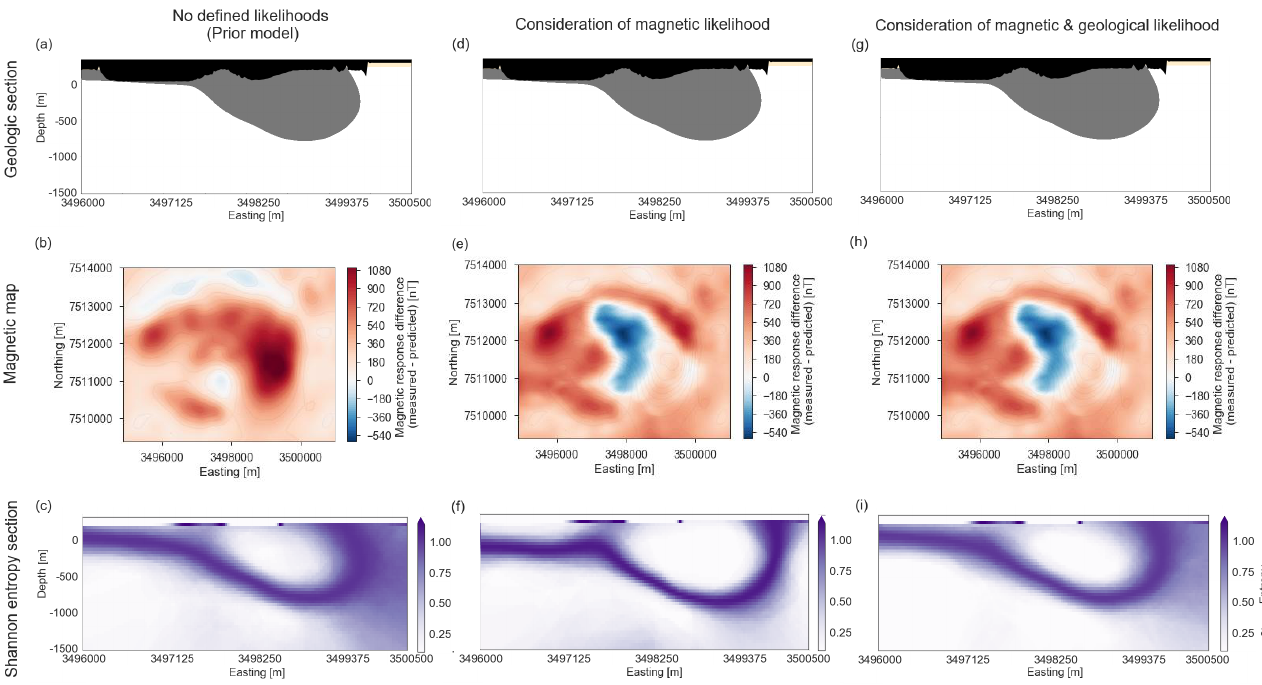
Figure 7. ( a ) Cross-section of the initial model; ( b ) difference map between the forward modeled magnetic response of the initial model and the magnetic measurements; ( c ) calculated entropy from all realized models based on assigned uncertainty in the initial model, where zero (white) corresponds to locations with no uncertainty (i.e., locations that have the same outcome in all realizations). ( d ) Cross-section of the Maximum A Posteriori (MAP) geological model based on magnetic constraints; ( e ) difference between the forward modeled magnetic response of the MAP model and the magnetic measurements; ( f ) calculated entropy from all realized models in the probabilistic inversion using only magnetic likelihoods. ( g ) Cross-section of the MAP model based on magnetic and additional geological constraints; ( h ) difference between the forward modeled magnetic response of the MAP model and the magnetic measurements; ( i ) calculated entropy from all realized models in the probabilistic inversion using magnetic and geological